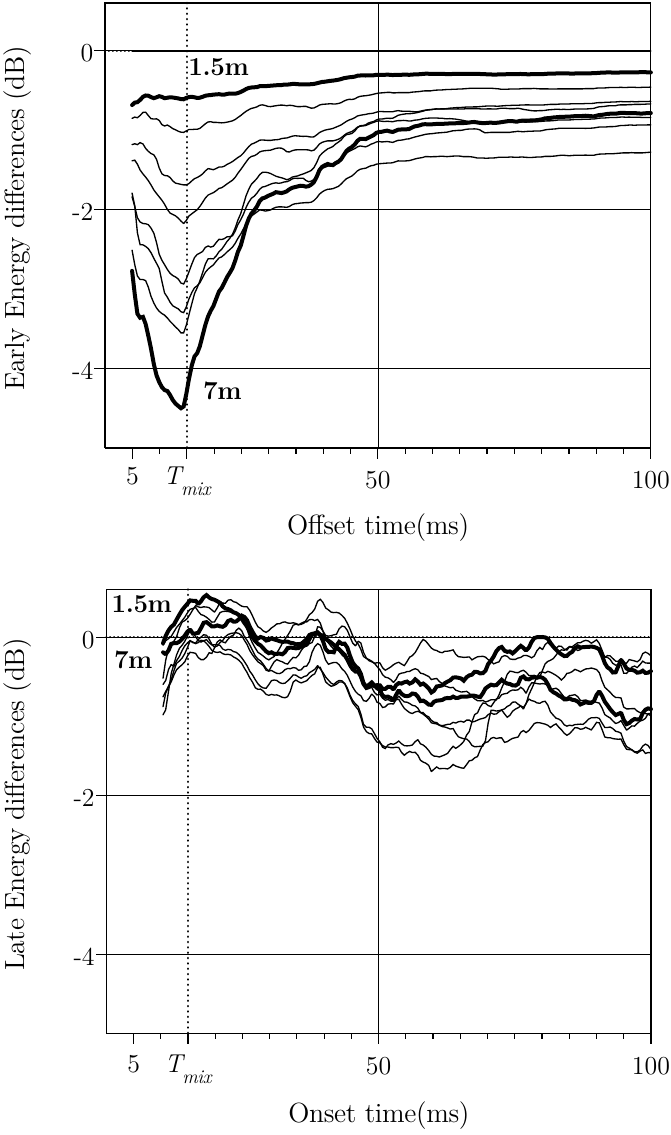
Figure 7. Early and late energy differences of the BRIRs generated with the envelope–based model compared to measured BRIRs. T mix = 15 ms corresponds to the transition time between the early and the late reverberation segments considered in the envelope-based model to generate the